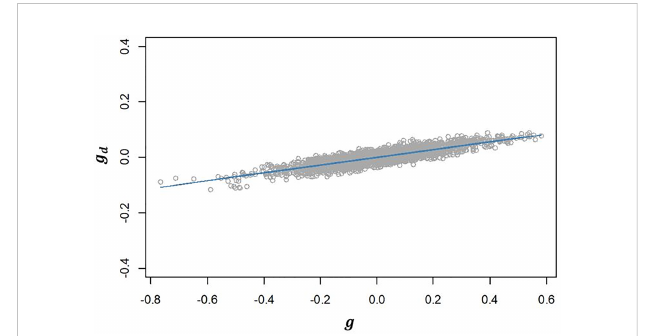
FIGURE 3 Regression of predicted additive genetic values for the dispersion variable ( g d ) after algorithm convergence on predicted additive genetic values for corrected phenotypes ( g ). The blue line represents the fi tted curve of the linear